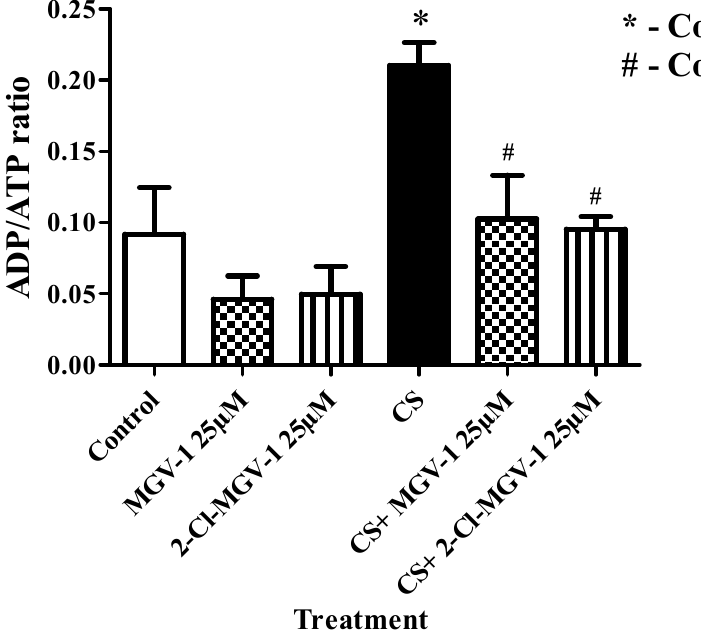
Figure 6. The ability of TSPO ligands against ATP synthase reversal induced by CS in H1299 lung cancer cells. ADP/ATP ratio measured by ELISA. ATP synthase activity was reversed due to CS exposure. The control, MGV-1 and 2-Cl-MGV-1 groups were exposed to fresh air only without exposure to CS. Results are represented as mean ± SEM ( n = 4 in each group). # p < 0.05 vs. CS and * p < 0.05 vs. control. CS = cigarette smoke.